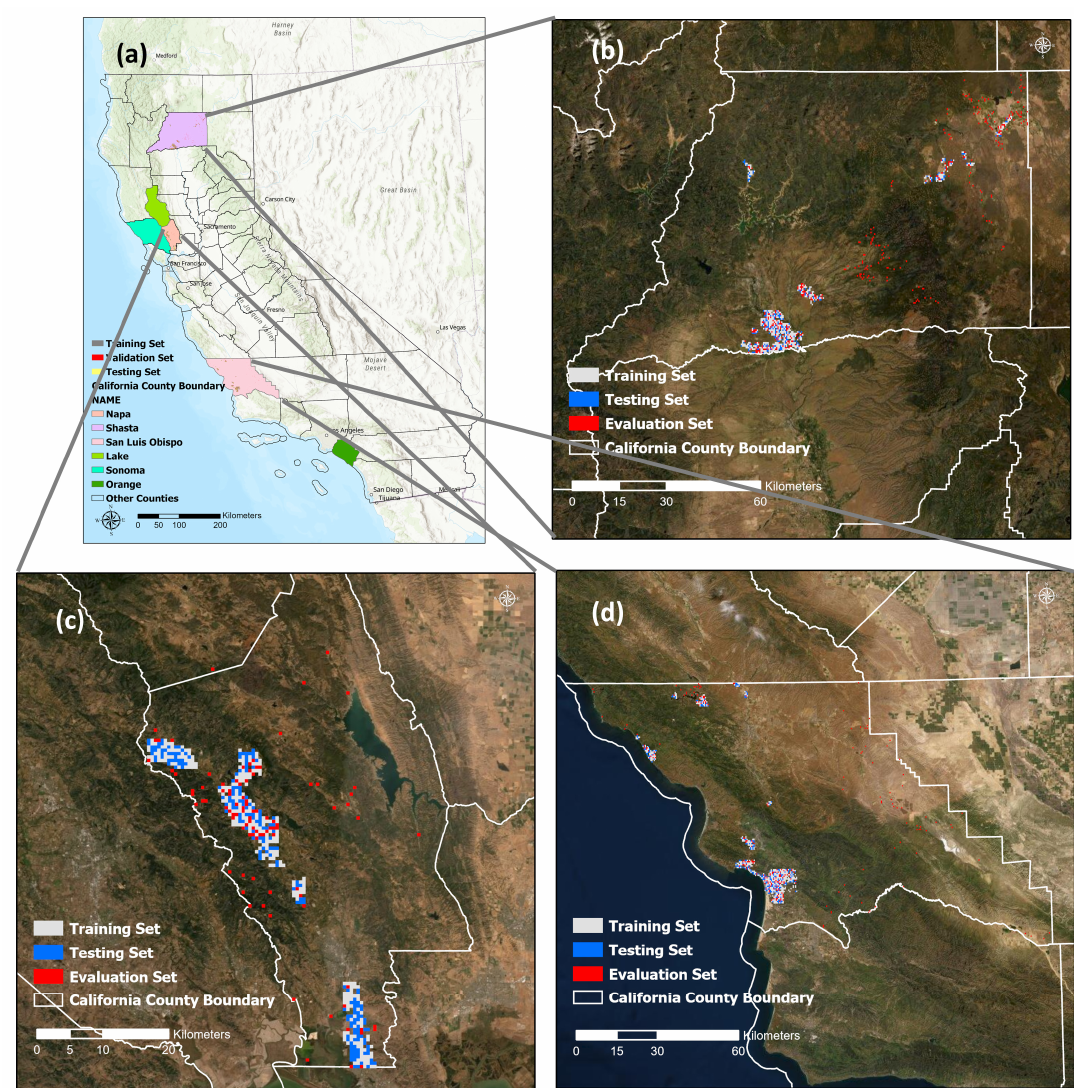
Figure 1. Foci of the study areas ( a ). NAIP image subsets from three counties, ( b ) Shasta, ( c ) Napa, and ( d ) San Luis Obispo were used to train and test the deep learning model. The model was applied to all NAIP imagery in Lake, Sonoma, and Orange Counties for building detection and WUI mapping every 2 years.